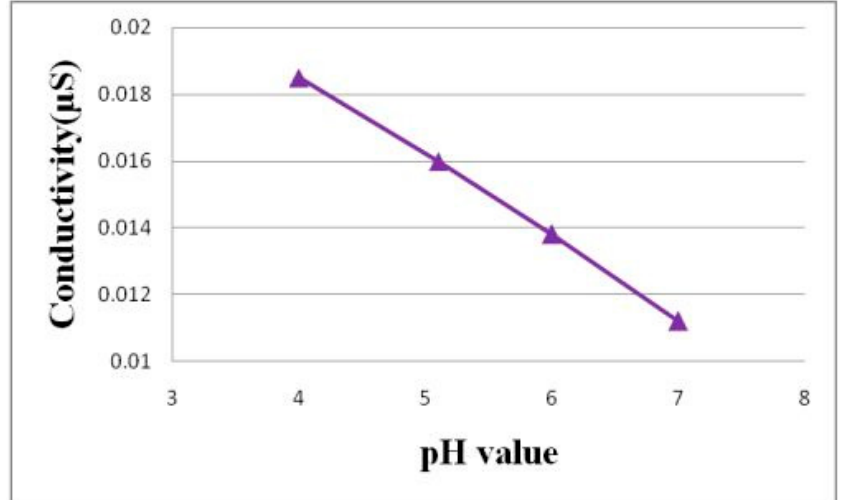
Figure 5. Calibration curve of the flexible micro pH sensor.